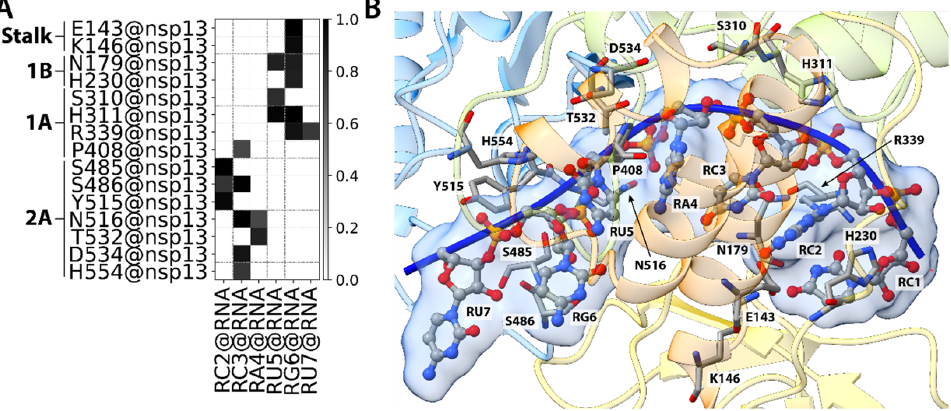
Figure 8. ( A ) Plot of the interface contact matrix between NSP13 and the RNA fragment present in the RNA-engaged form. Contacts are colored from white to black if they were observed in 0% or 100% of the simulation time, respectively. In Panel ( B ), a detail of the RNA–NSP13 interface taken from the representative structure of the most populated cluster is shown. The ribbons are colored as in Figure 1C, while the NSP13 residues involved in a contact lasting for at least 50% of the simulation time are reported as sticks, and the RNA nucleotides are shown as balls and sticks. All atoms are colored according to the atom type.